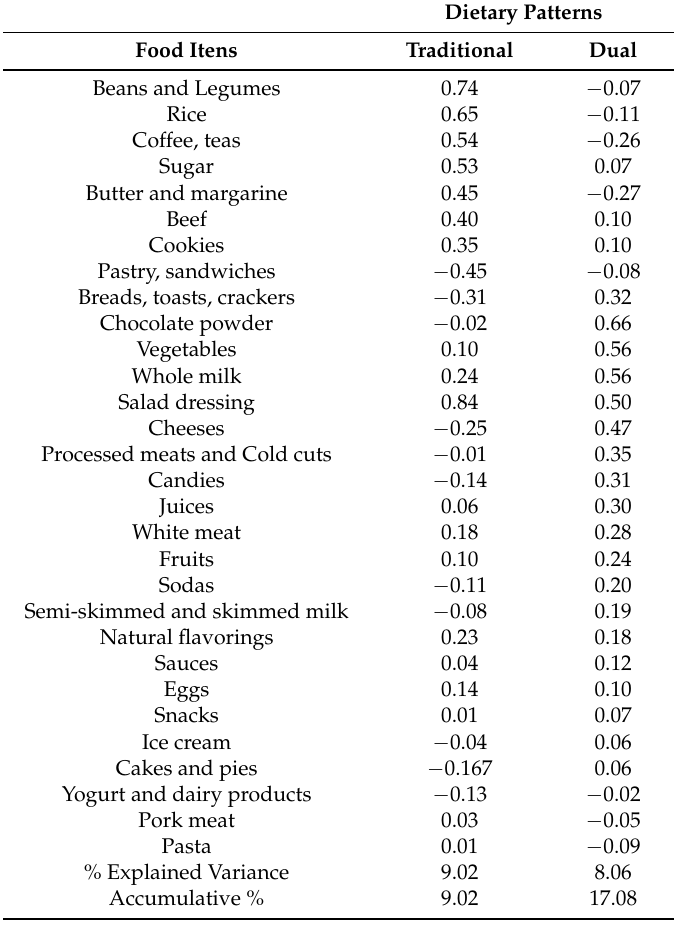
Table 3. Factor loading for dietary patterns obtained in factor analysis ( n = 229). São Paulo. Dietary Patterns Food